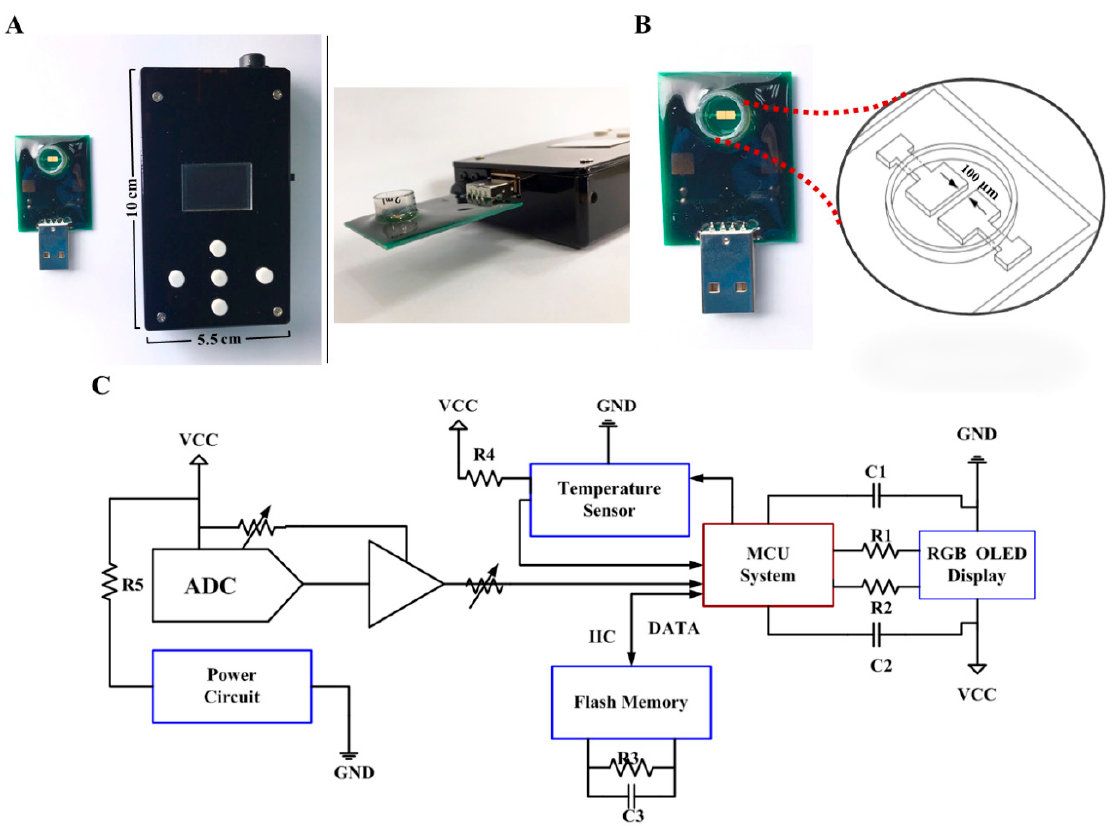
Figure 1. A tailor-made portable biodevice for measuring conductivity. ( A ) The device is composed of two parts, including a PCB with a coating-free gold microelectrode sensor in the sample well and a conductivity meter with a size of 10 × 5.5 × 2.2 cm 3 . ( B ) Design of the co-planar microelectrode and the sample well. The gap between two microelectrodes is only 100 µ m. ( C ) Electronic schematics of the fabricated conductivity meter. Abbreviations: ADC, analog-to-digital converter; C, capacitance; GND, ground; IIC, inter-integrated circuit; MCU, micro control unit; OLED, organic light-emitting